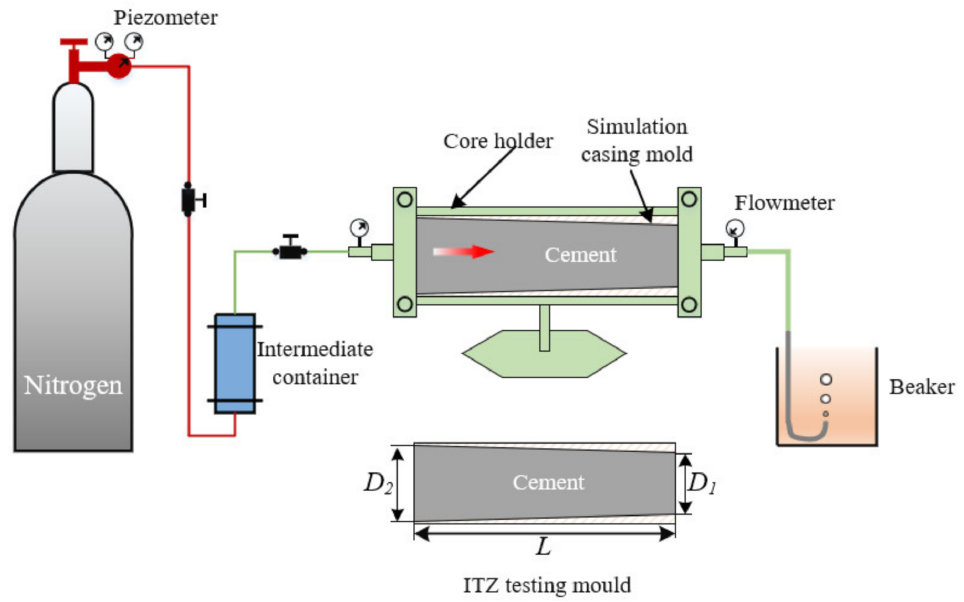
Figure 4. Schematic diagram of breakthrough-pressure-testing